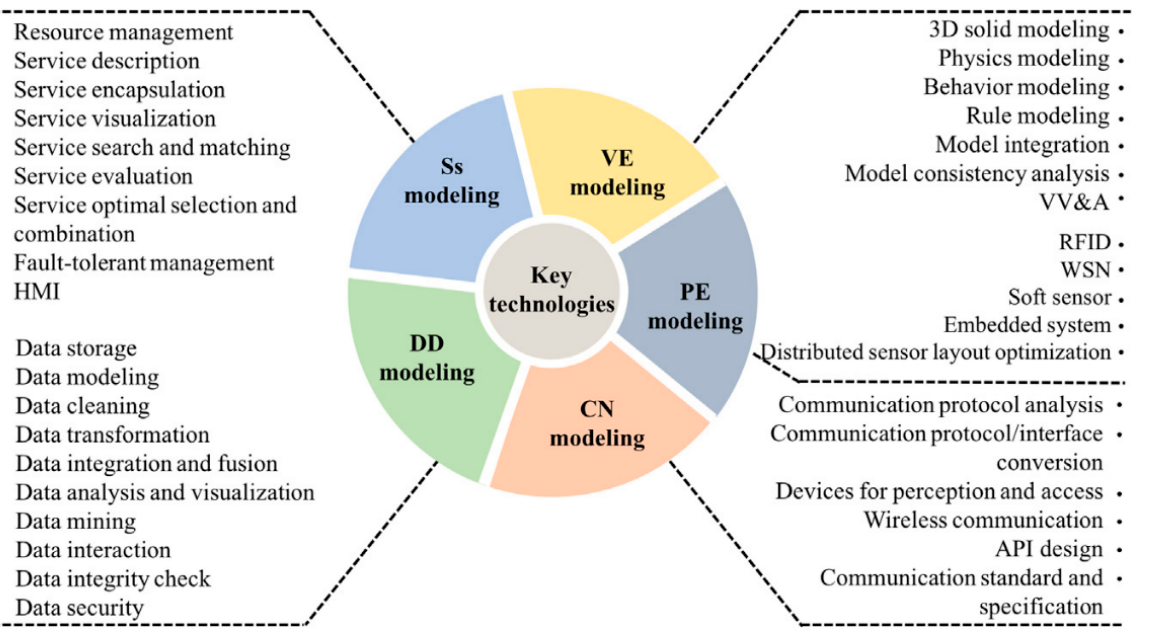
Figure 2. Five-dimensional digital twin model and the key technologies. PE—Physical Entity, VE— Virtual Entity, Ss—Services, DD—Digital twin data, CN—Connection. Reproduced from [35], with permission from Elsevier, 2022.